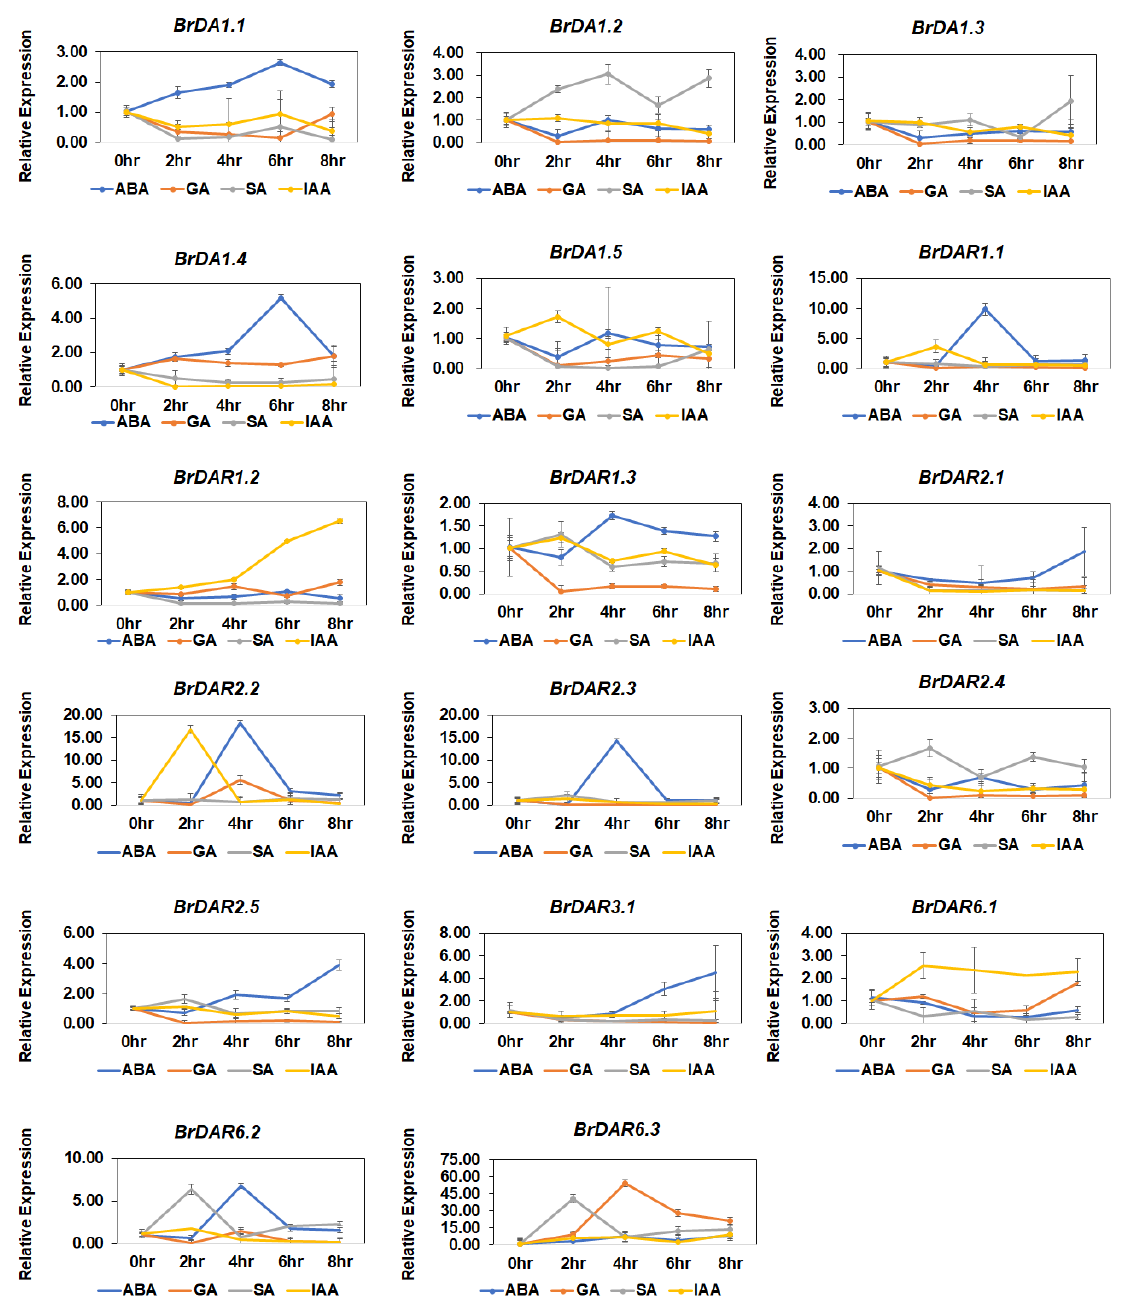
Figure 8. Expression profiling of BrDA1 & DAR under different phytohormones (ABA, GA, SA, and IAA). 0 h, 2 h, 4 h, 6 h, and 8 h are the time intervals of sampling after treatment, and graphs represent relative gene expression examined through the 2 − ∆∆ CT method.